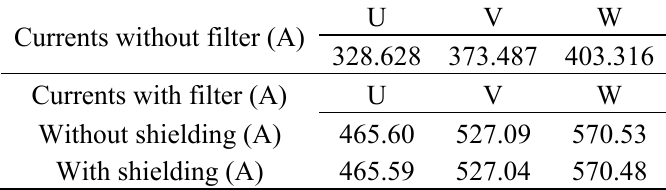
Table 1. Coupling and shielding influences on the currents of floating potentials tracks.